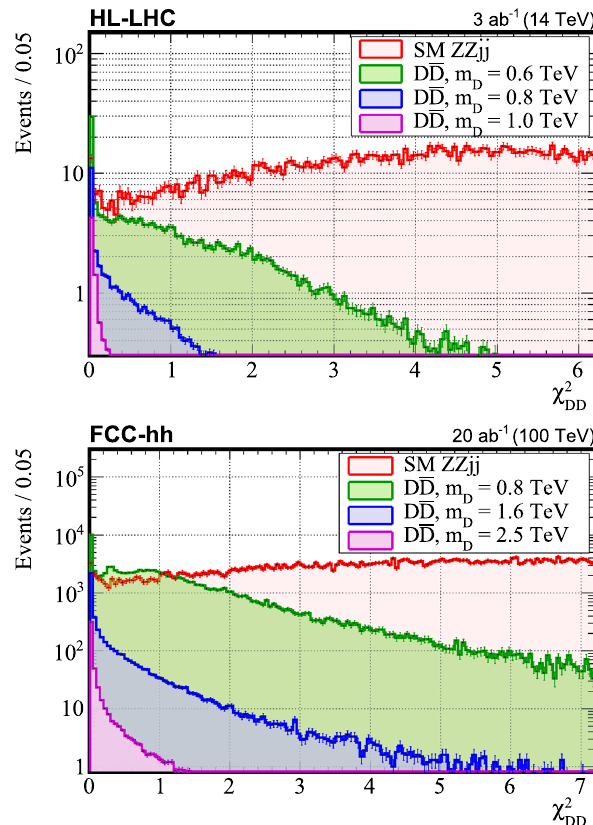
Fig. 5 Distribution of angular distance between the two reconstructed D quarkcandidates D 1 and D 2 forHL-LHC(top)andFCC-hh(bottom) conditions. The jets are selected by minimizing the condition defined in Eq. 4